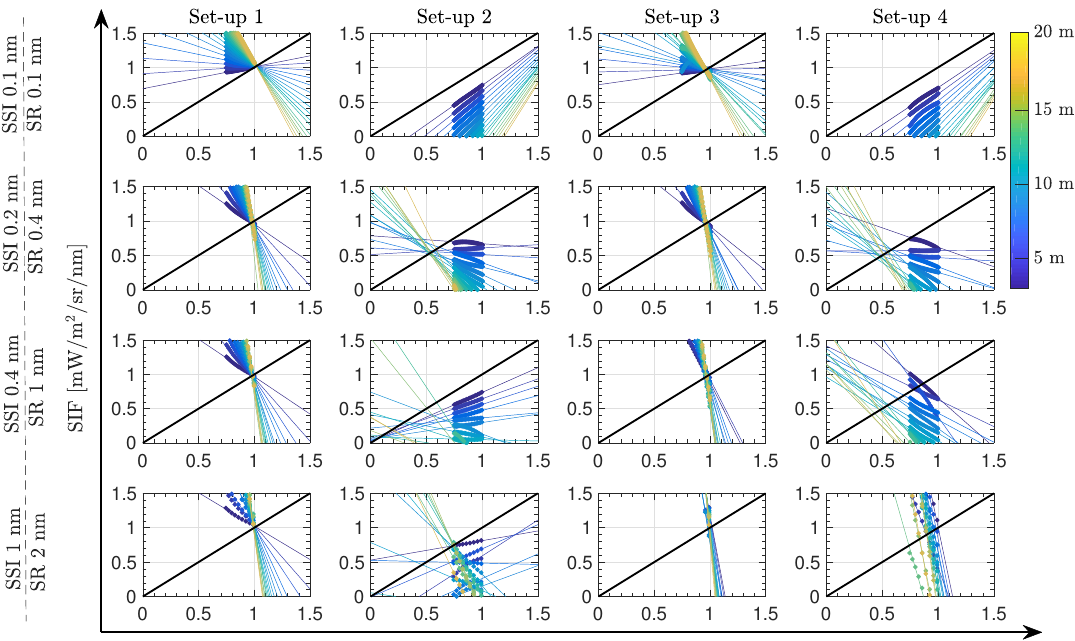
Figure 11. Scatter plots of reference SIF versus estimated SIF spectra in the interval between 759.0–767.5 nm using the SFM retrieval approach and O 2 compensation while ignoring instrument spectral convolution effects for set–up configurations 1–4. Simulations are shown for different instrument resolutions (rows 1–4) and sensor heights between 3 m to 20 m (colour scale). Solid lines are regression lines. Actual estimations are presented as